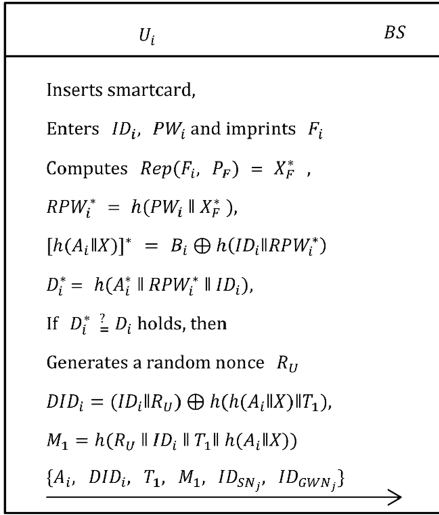
Figure 6. Login phase of the proposed scheme.